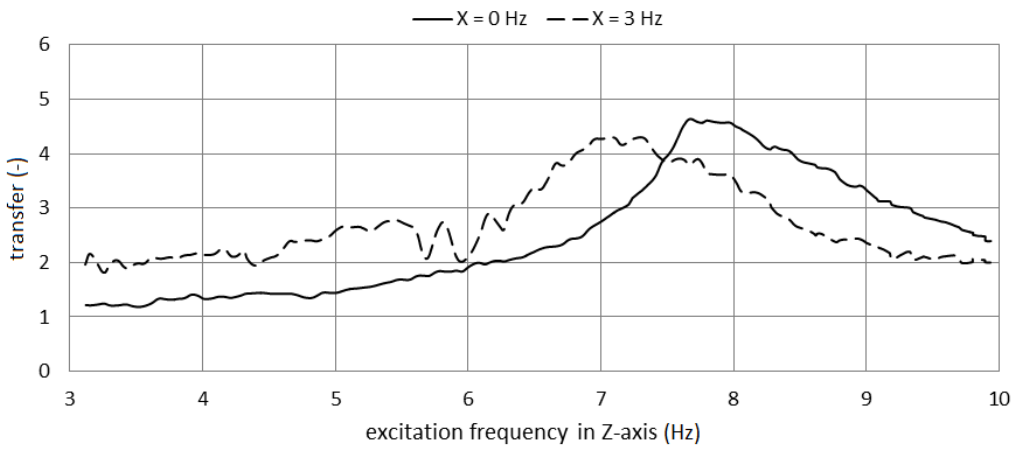
Figure 11. Transfer for Z-axis excitation 3 to 10 Hz and excitation in X-axis 3 Hz.